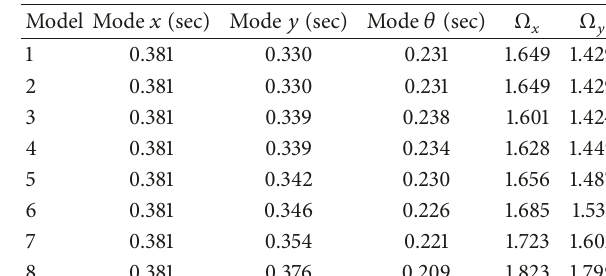
Table 3: Natural period and torsional to lateral frequency ratios ( Ω ) of models with rigid diaphragm